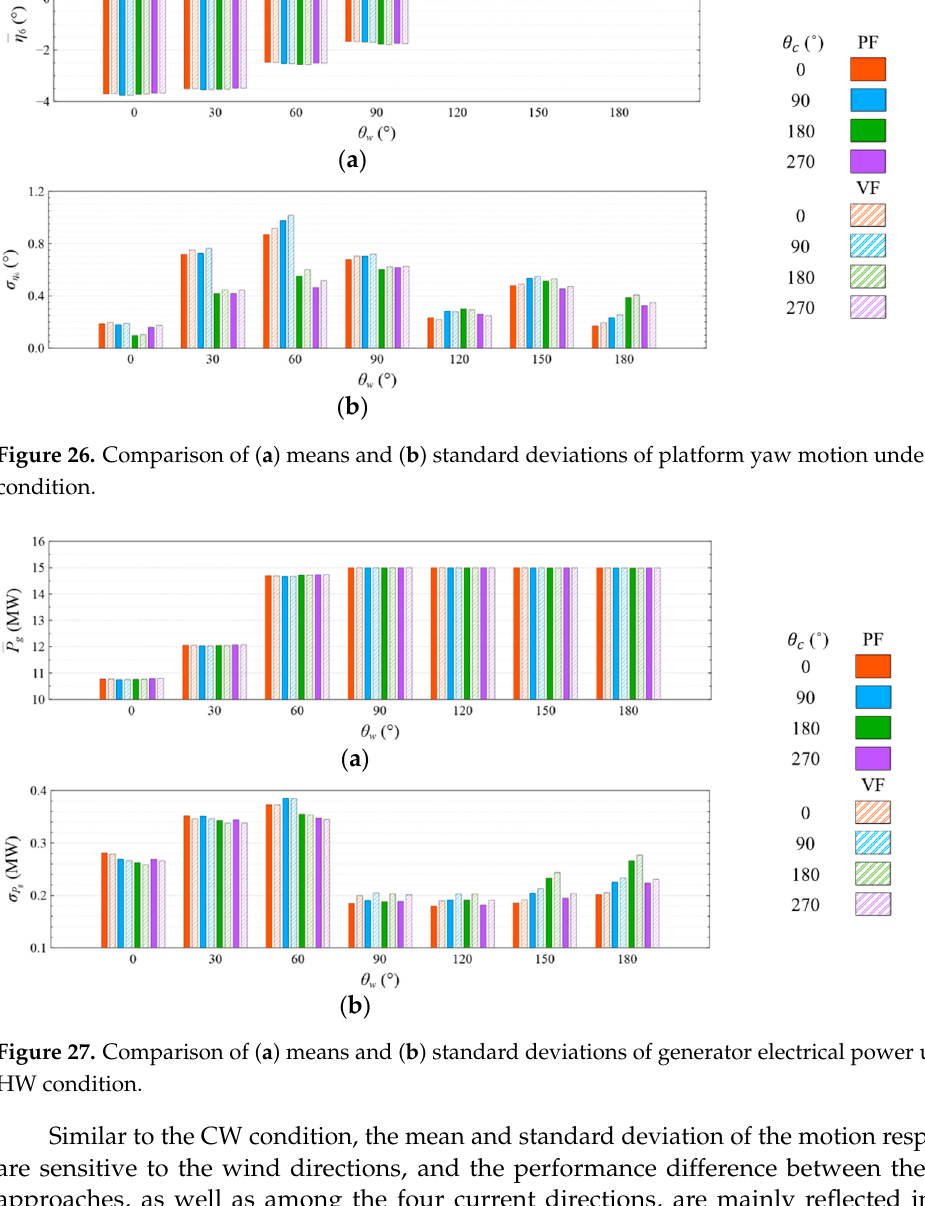
Figure 25. Comparison of ( a ) means and ( b ) standard deviations of platform pitch motion under HW condition.